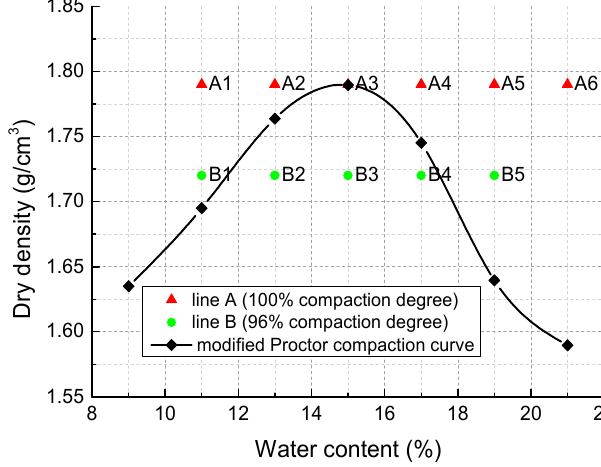
Figure 6. Modified Proctor compaction curve and the molding points.